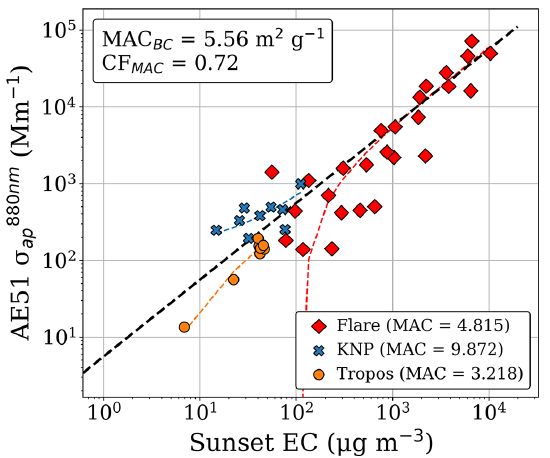
Figure 7. Determination of the MAC value as the slope of the ab- sorption coefficient at 880nm from the AE51 and the EC desorbed from the quartz-fibre filters, determined by the Sunset